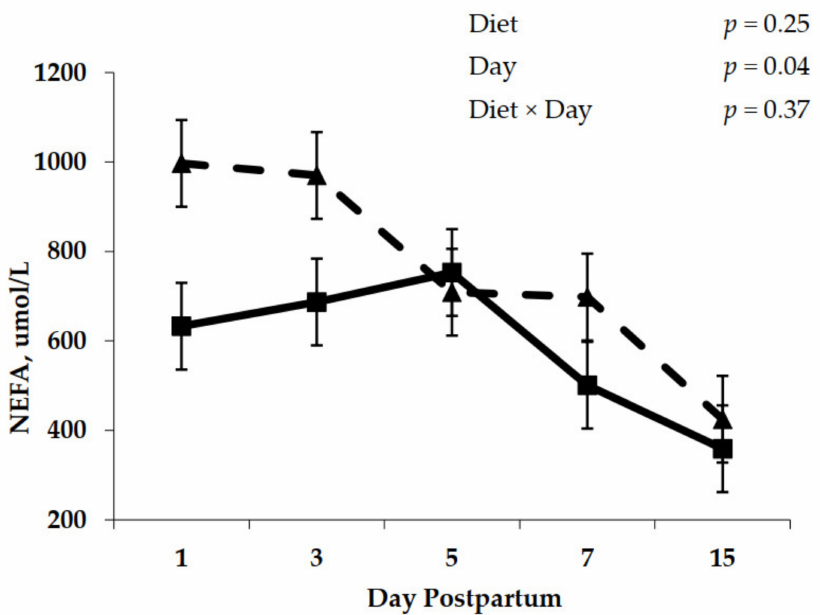
Figure 1. Postpartum plasma non-esterified fatty acids (NEFA) concentration for cows fed control (triangles) or molasses-containing (squares) diets during a 60 day dry period (error bars = pooled standard error of the mean; Experiment 2, n = 3)